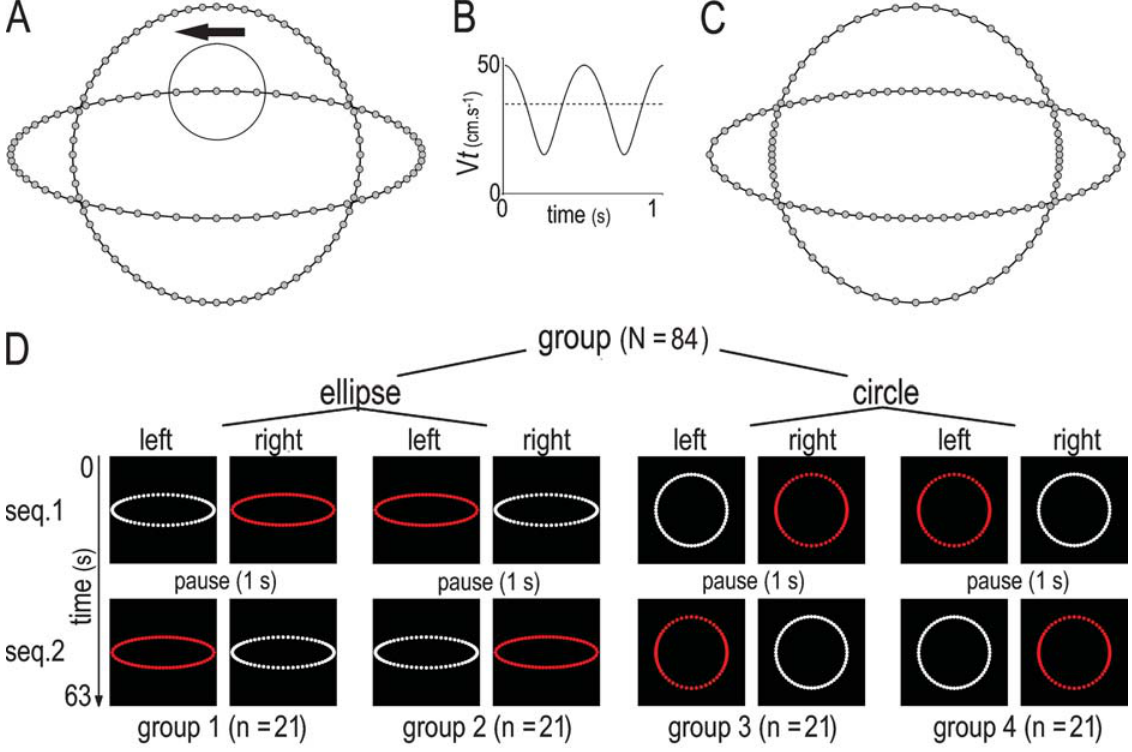
Figure 1. Stimuli and Experimental Design. (A) Geometry (line) and Cartesian coordinates (markers) of the biological stimuli. The arrow indicates the direction of motion. The circular outline shows the starting position and the relative size of the light-spot with respect to the trajectory. (B) Tangential velocity of the elliptical (line) and circular (dashed line) biological stimuli. (C) Non-biological motions derived from the biological coordinates. Geometry and kinematics were inverted. (D) Experimental design. The neonates were assigned to one of the four sub-groups defined by the combination of the stimulus geometry (ellipse or circle) and of the screen (left or right) displaying the biological motion (white points)